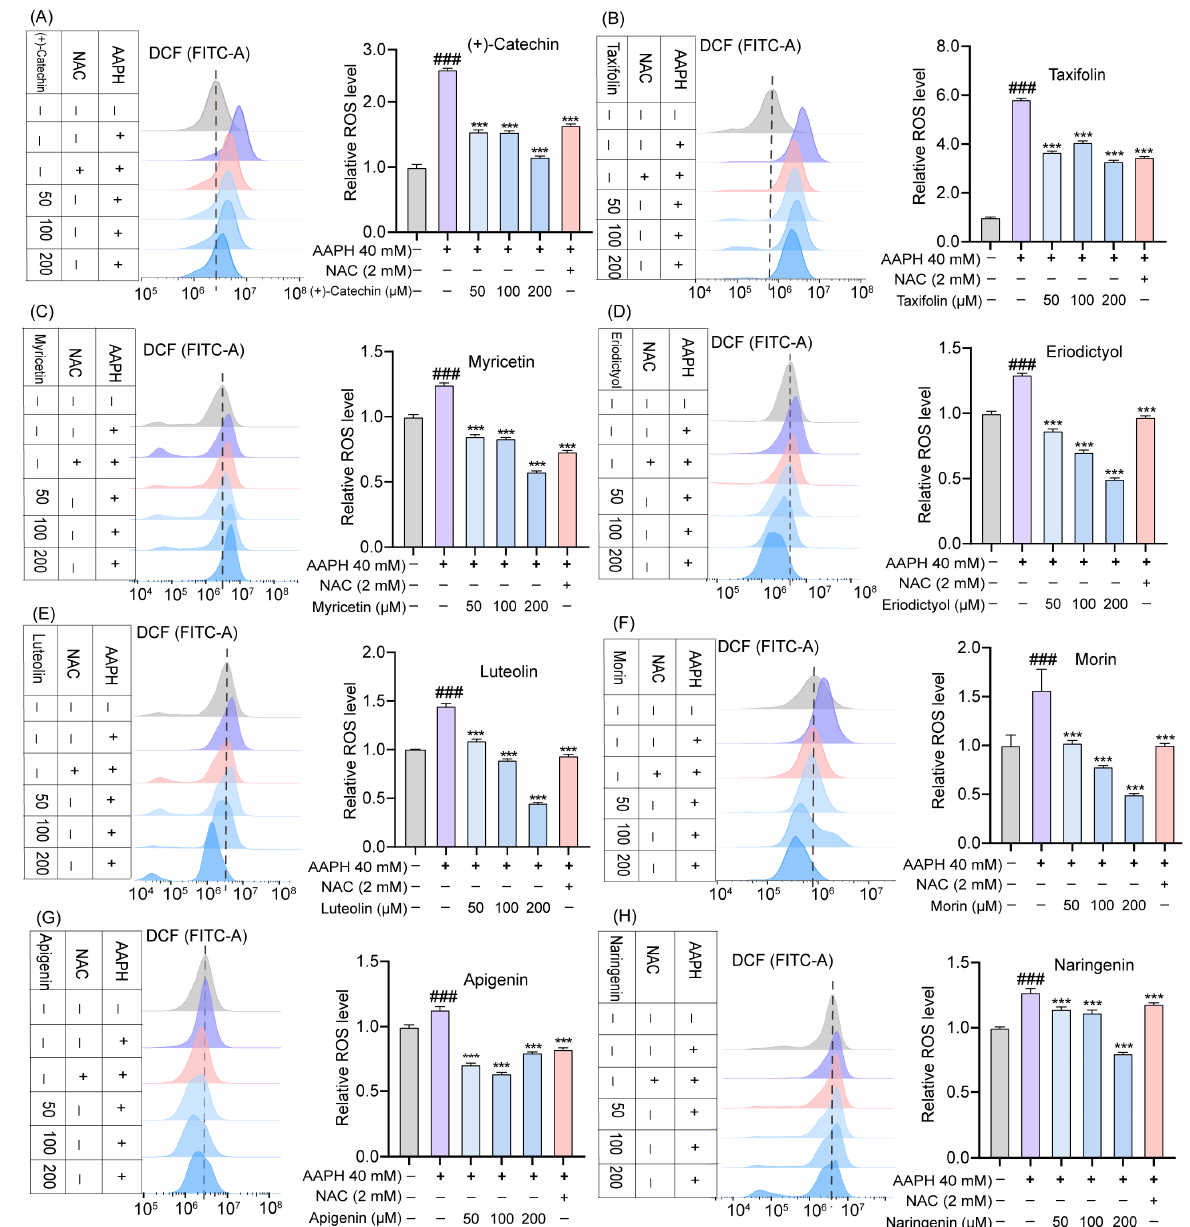
Figure 5. ( A – H ) ROS levels in AAPH-treated ATDC5 cells treated with the flavonoids of TSE (50–200 µ M). NAC (2 mM) acts as a positive control. n = 5. Data were expressed as mean ± SD and the statistical differences were analyzed by one-way ANOVA followed by LSD multiple comparisons test (IBM SPSS Statistics 25.0, Armonk, NY, USA). ### p < 0.001 vs. the control group. *** p < 0.001 vs. AAPH group.